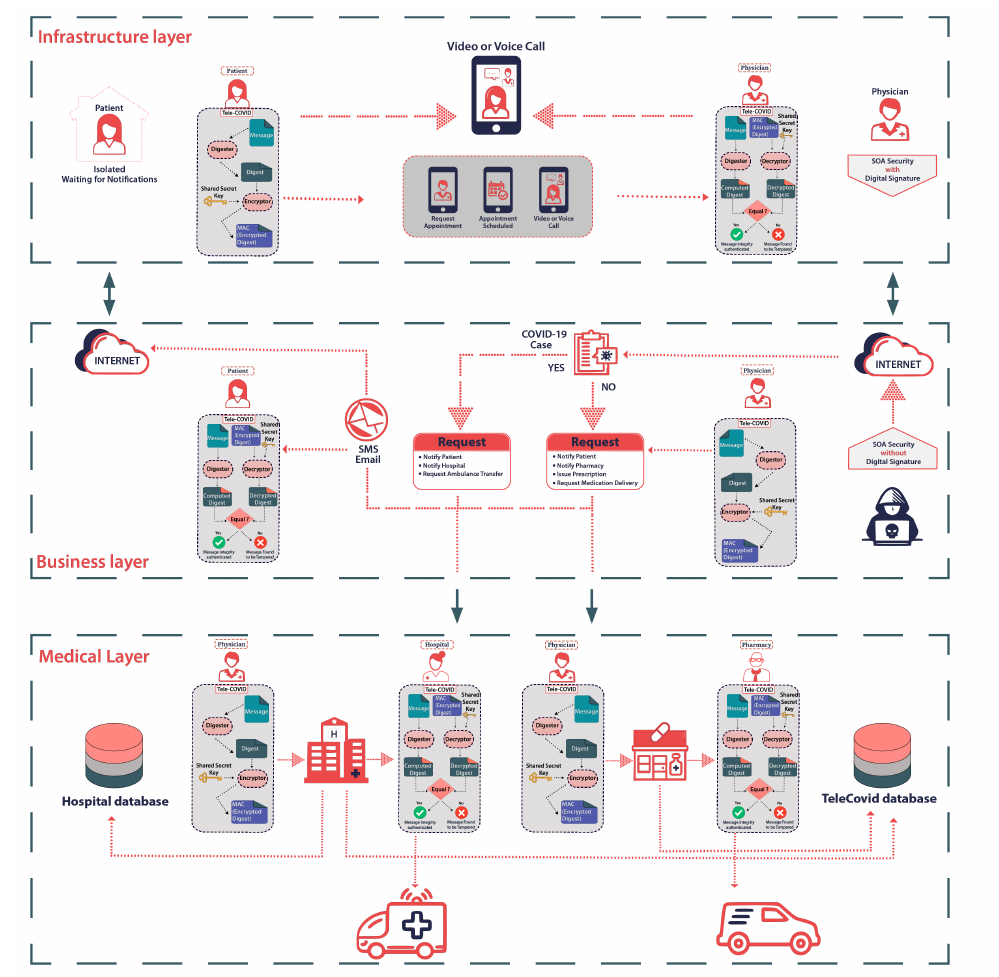
Figure 5. SOA Security architecture of